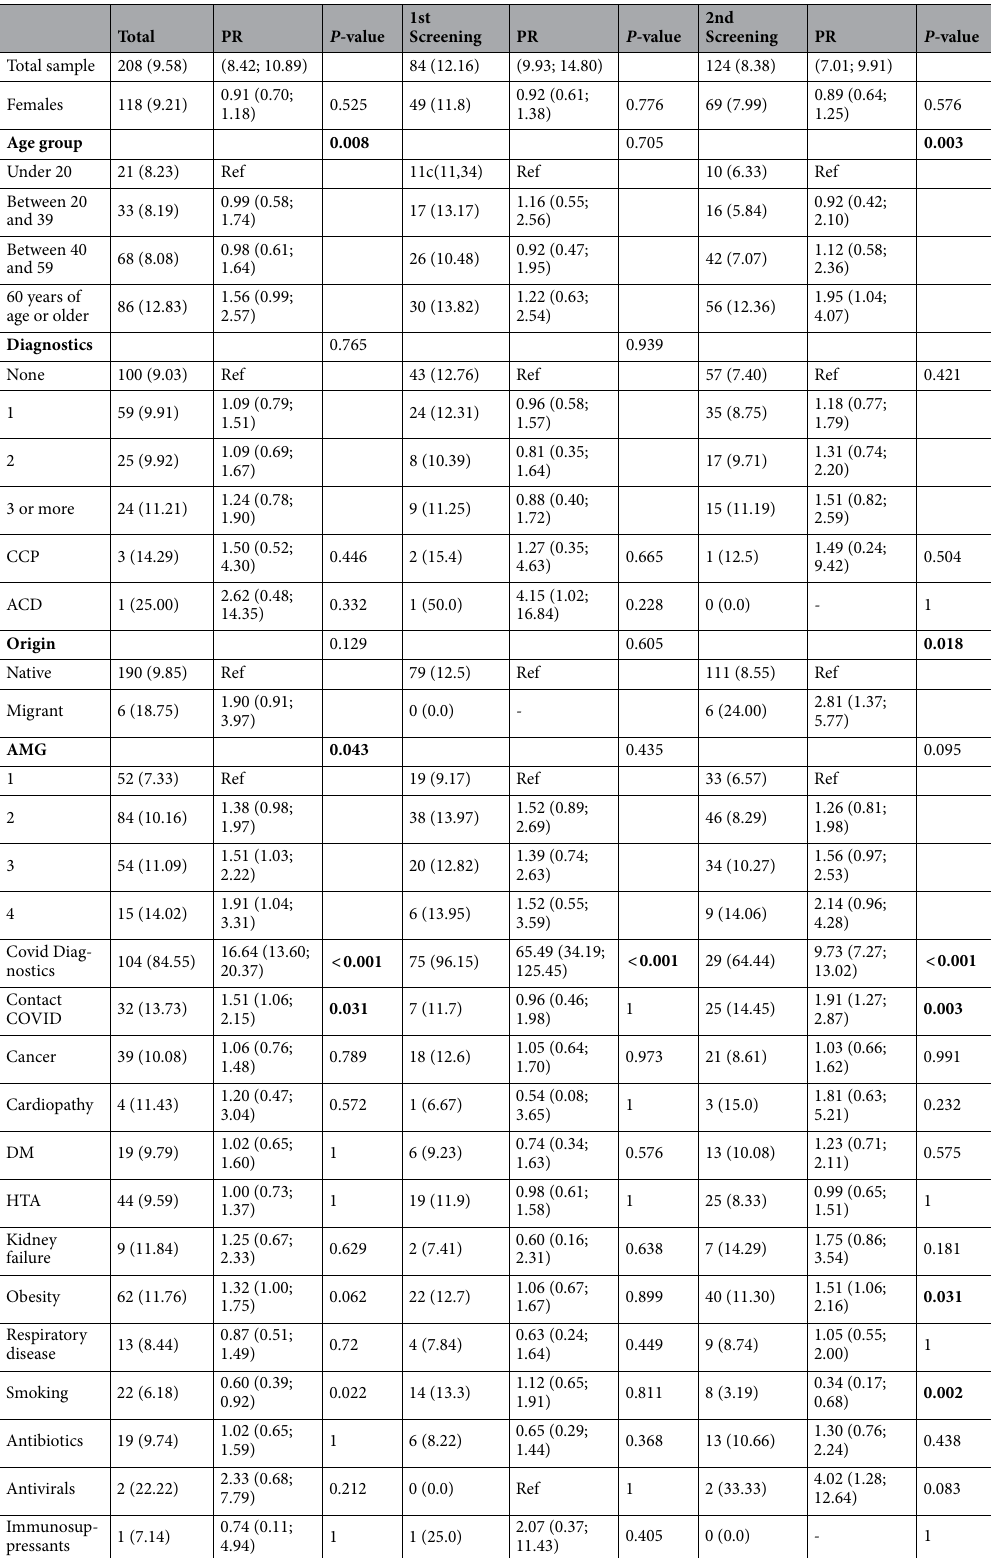
Table 2. Prevalence and prevalence ratio of the variables analysed, in the total sample and in the first and second screening. * They are represented by n and percentages. The reference category for comparison has been the No condition. No significances were detected in multivariate adjusted